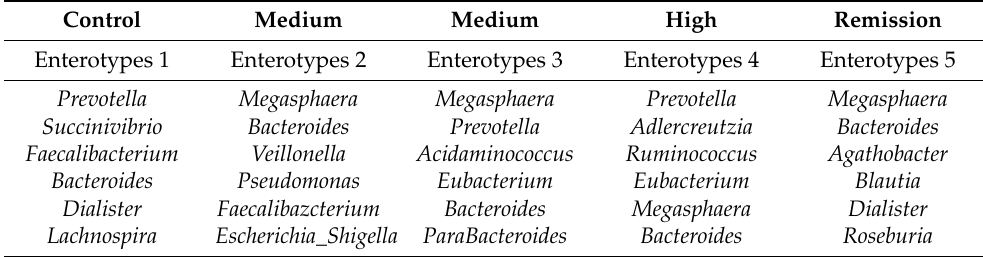
Table 2. Enterotypes detected in the gut microbiome of healthy participants and RA